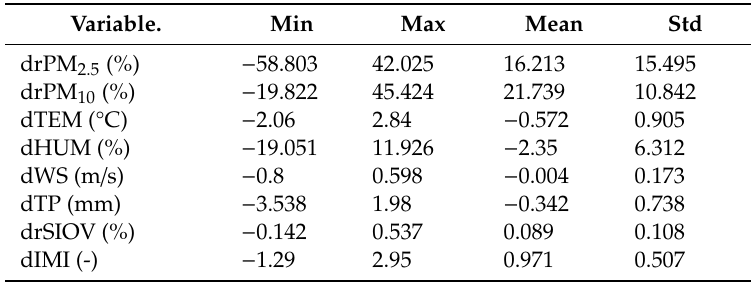
Table 1. Some information about